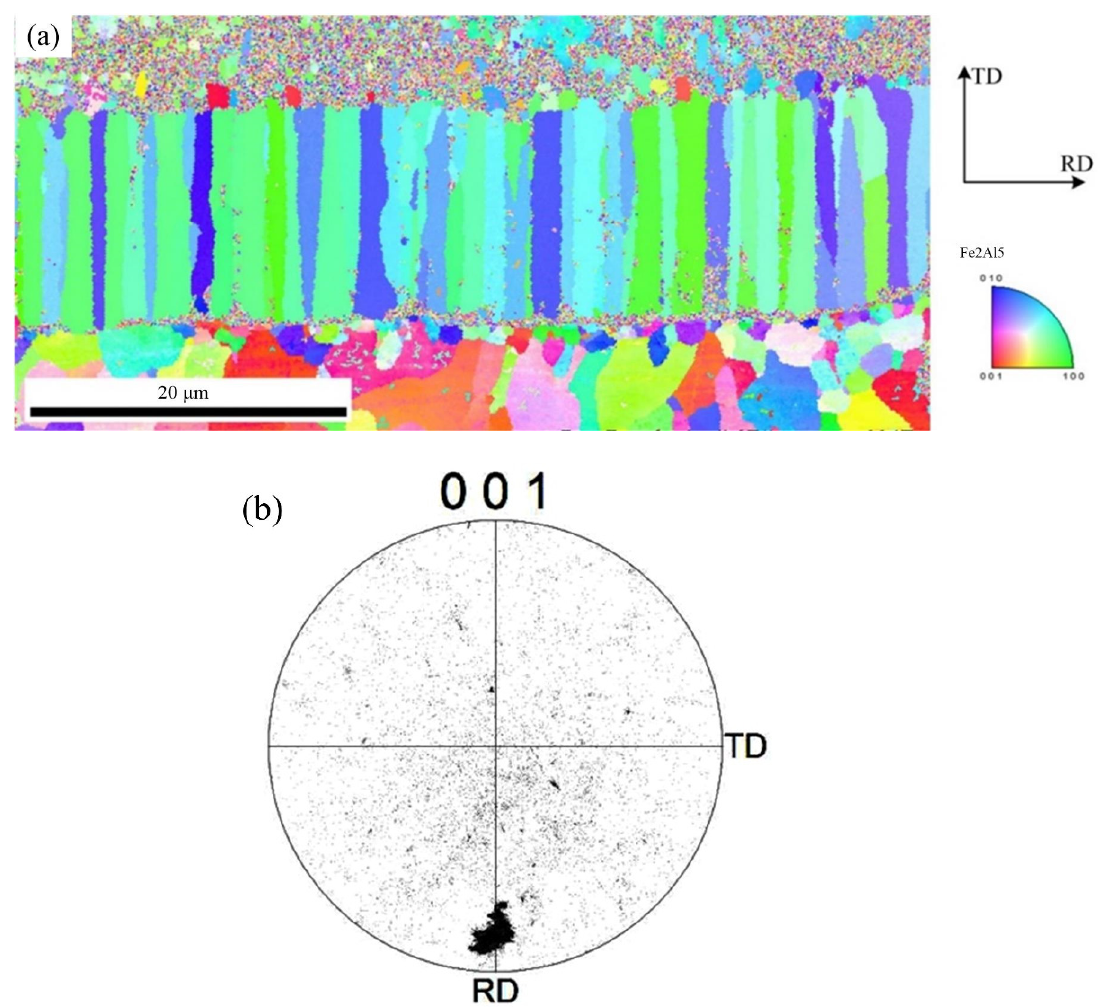
Figure 8. EBSD image of Fe 2 Al 5 phase: ( a ) inverse pole figure map and ( b ) crystal orientation.